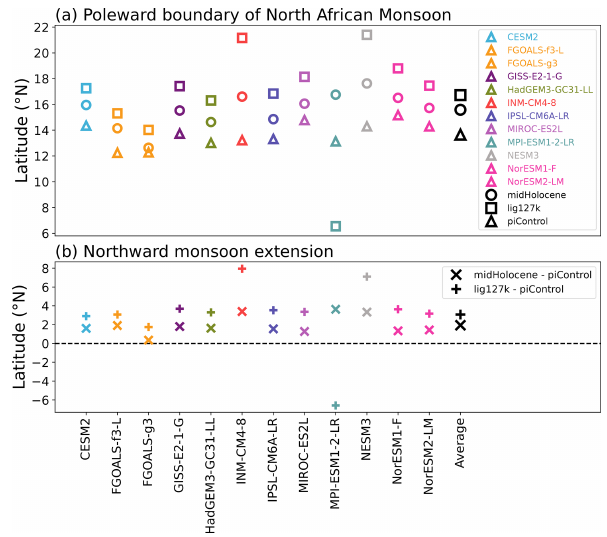
Figure 8. NAF poleward extension in the PMIP4-CMIP6 midHolocene and lig127k ensembles. (a) The latitude of the pole- ward boundary of the NAF in the simulations and (b) the northward monsoon extension. The boundary is the latitude where the zonal mean summer (MJJAS) rain rate equals 2mmd − 1 over north Africa (15 ◦ W–30 ◦